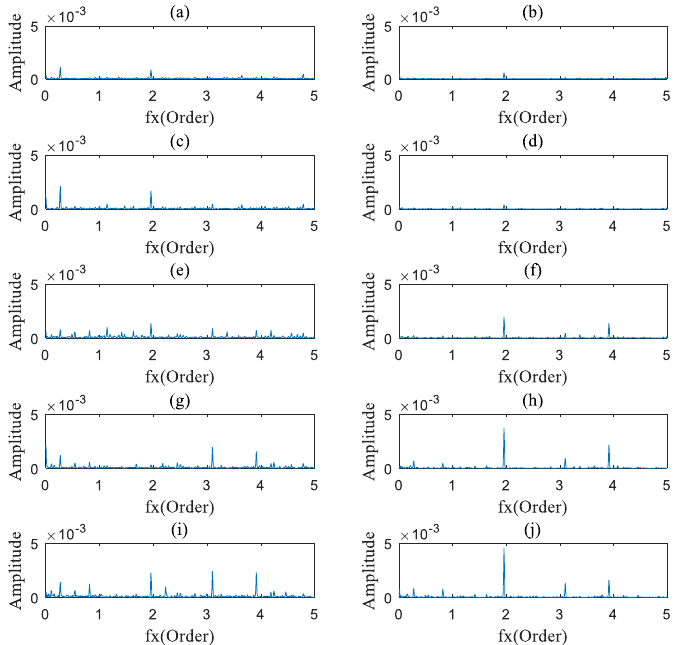
Figure 12. The characteristic slice under 40% rated speed conditions: ( a ) Healthy PG at 0% rated load; ( b ) Pitting fault on sun gear of PG at 0% rated load; ( c ) Healthy PG at 25% rated load; ( d ) Pitting fault on sun gear of PG at 25% rated load; ( e ) Healthy PG at 50% rated load; ( f ) Pitting fault on sun gear of PG at 50% rated load; ( g ) Healthy PG at 75% rated load; ( h ) Pitting fault on sun gear of PG at 75% rated load; ( i ) Healthy PG at 90% rated load; ( j ) Pitting fault on sun gear of PG at 90% rated